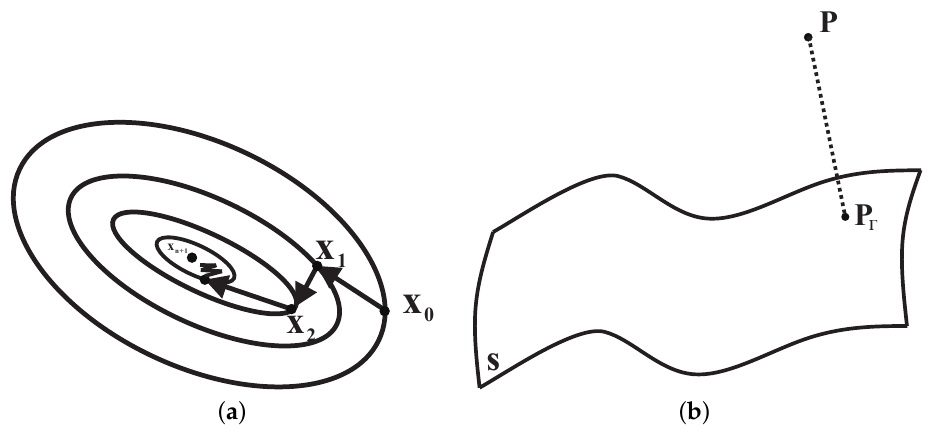
Figure 2. The complete schematic of Algorithm 1. ( a ) Newton’s gradient descent method; ( b ) Point orthogonal projection onto algebraic surface. All the curves of figures ( a ) denote contour surfaces and not contour